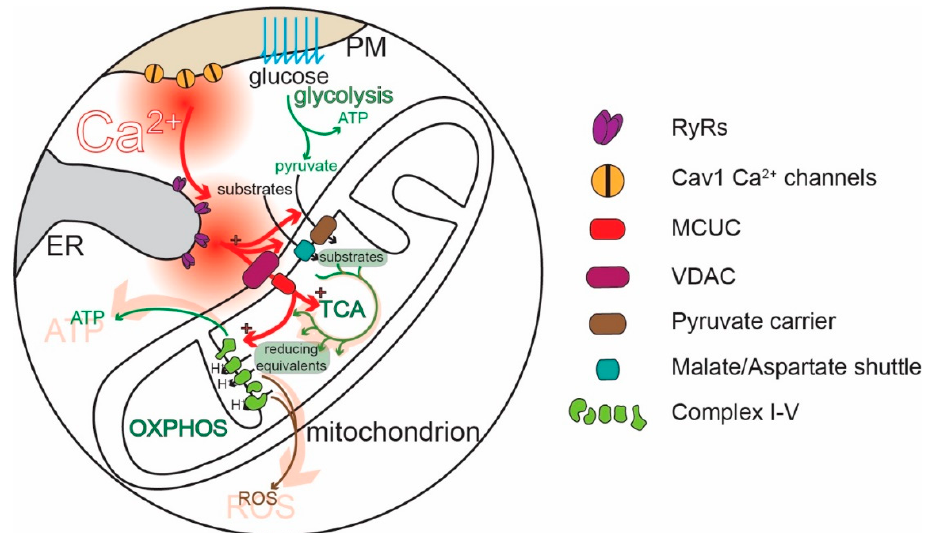
Figure 2. Effects of Ca 2+ on mitochondrial bioenergetic metabolism and reactive oxygen species (ROS) production. The two primary sources of ATP in neurons are glycolysis and mitochondrial OXPHOS. During pacemaking, Ca 2+ entry through Cav1 channels, coupled with CICR through RyRs, generates an elevation in [Ca 2+ ]. Elevated [Ca 2+ ] reaching the mitochondria favors the uptake of substrates by the mitochondria by acting on transporters and carriers on the IMM; Ca 2+ taken up by mitochondria through the voltage-dependent anion channel (VDAC) and MCUC increases OXPHOS by enhancing the activity of the TCA cycle and by stimulating ATP synthesis by Complex V. The downside of this stimulation is an increase in the generation of ROS.